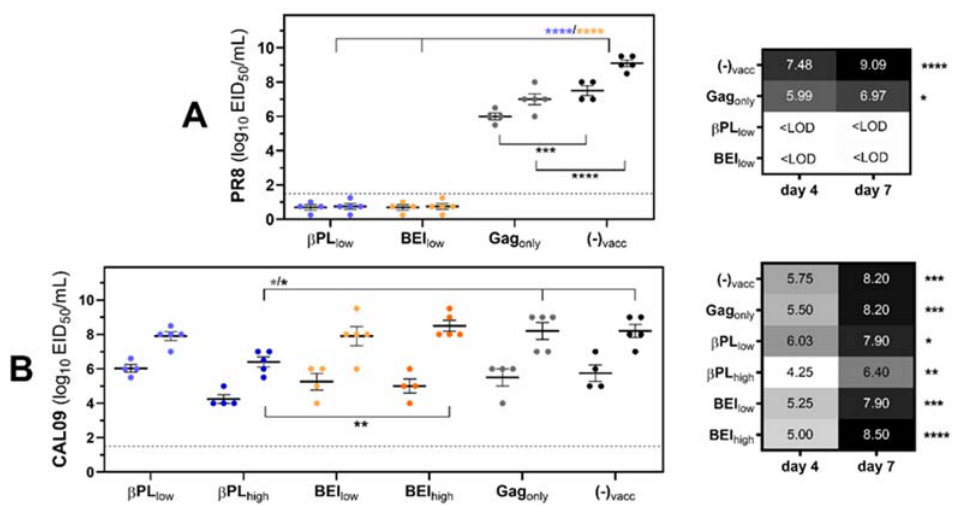
Figure 4. Neutralizing and non-neutralizing anti-influenza HA immunity restrains viral replication and viral rebound after secondary pneumococcus infection. Mice received one intraperitoneal dose of the respective preparations or bu ff er, and on day 21 were intranasally infected with influenza followed by S. pneumoniae challenge five days later. Viral pulmonary loads were analyzed in mice ( n = 4–5 per group) infected with ( A ) 100 TCID 50 of homologous influenza PR8 or ( B ) 1000 TCID 50 of homosubtypic heterologous CAL09. Figures give viral day four titers (one day before bacterial challenge) juxtaposed with day seven titers (two days post bacterial challenge) for each vaccine group. Color code vaccine groups: β PL low (light blue), β PL high (dark blue), BEI low (light orange), BEI high (dark orange), Gag only (grey), non-vaccinated (black). Symbols represent the titer of an individual mouse and lines and error bars indicate group mean titers +/ − SEM. Heatmaps display group mean viral pulmonary titers on day four and day seven. The dashed line at 1.5 log 10 EID 50 / mL indicates the LLOD. Viral titers were log-transformed and di ff erences between groups and between days were analyzed by Two-Way ANOVA followed by a Tukey posthoc test or a Sidak posthoc test, respectively, with * p adj < 0.05, ** p adj < 0.01, *** p adj < 0.001, and **** p adj < 0.0001.